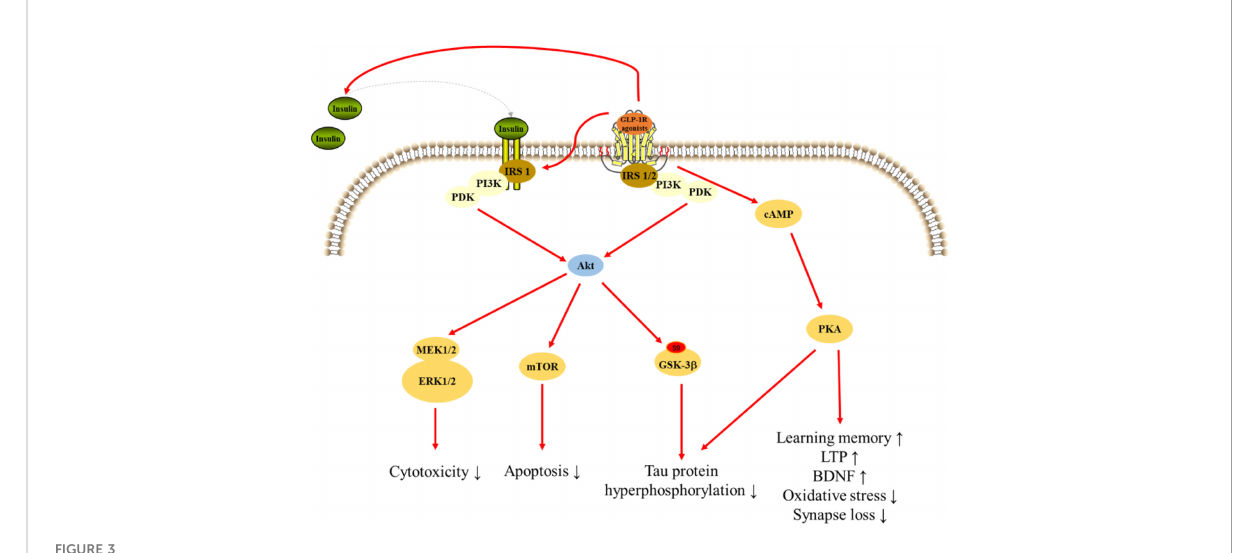
FIGURE 3 Signaling pathways for GLP-1R agonists in regulating cellular events in